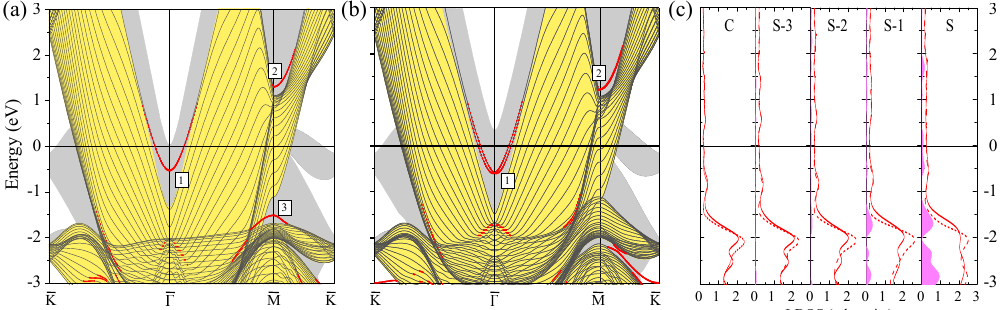
Figure 4. The electronic structure of the Au(111) surface calculated for the 23 monolayer thick slab without ( a ) and with ( b ) spin–orbit interaction. The surface states and resonances are indicated by red dots. The surface states discussed in the text are labeled by symbols. In ( a ) and ( b ), the continuum of the projected bulk electronic states for the Au(111) surface is shown by the yellow color while the portion of the projected bulk electronic structure for Pt(111) located outside this continuum is presented by the grey color. In ( c ), the layer density of states is shown for the top four and the central atomic layers. Pink regions show the excess of LDOS in a given layer in comparison with the bulk